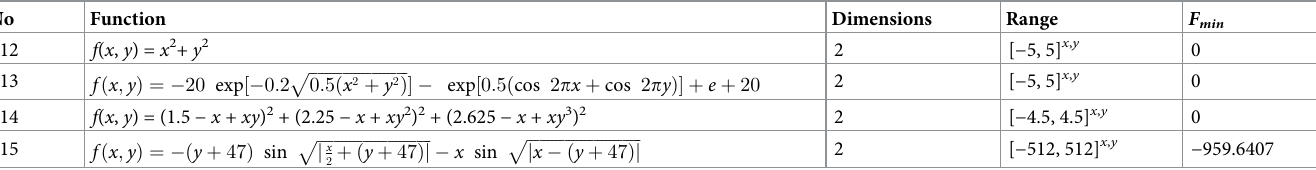
Table 3. Details of fixed-dimension test functions.